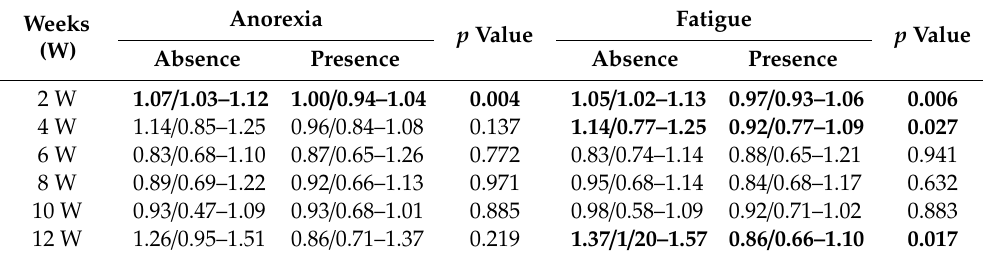
Table 1. Relationship between post- / pretreatment ratio of M-CSF and anorexia or